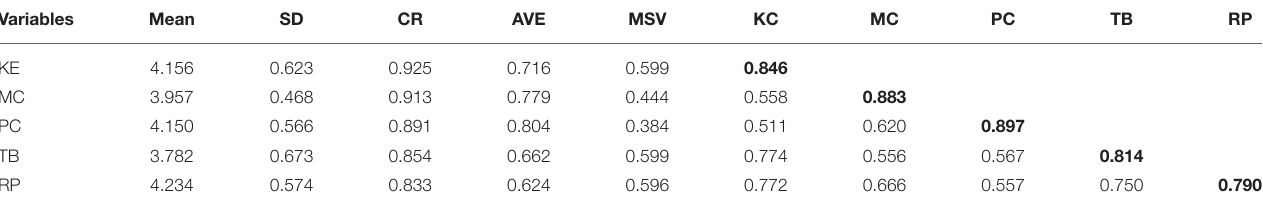
TABLE 3 | Mean, SD, and correlations. Variables